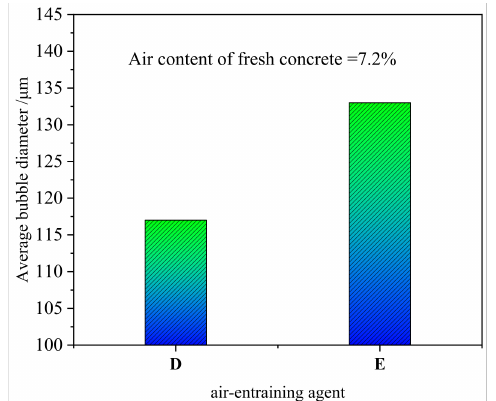
Figure 13. Effect of air-entraining agents D and E on the average bubble diameter.